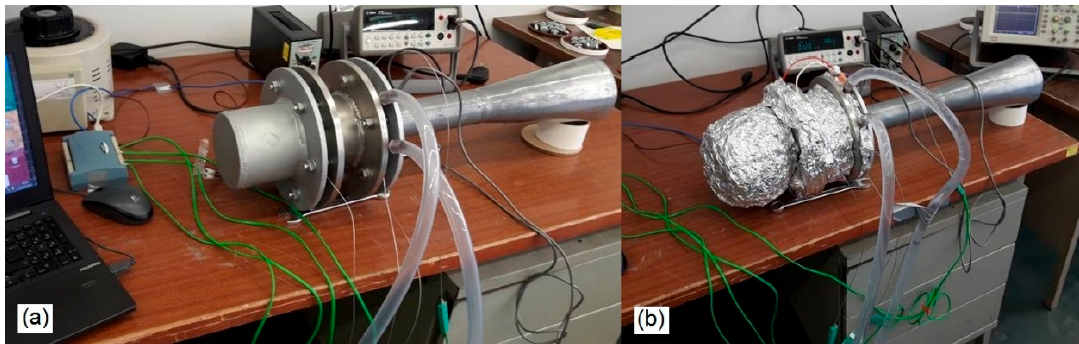
Figure 5. The standing wave test engine; ( a ) without thermal insulation (rock wool) and ( b ) with thermal insulation.